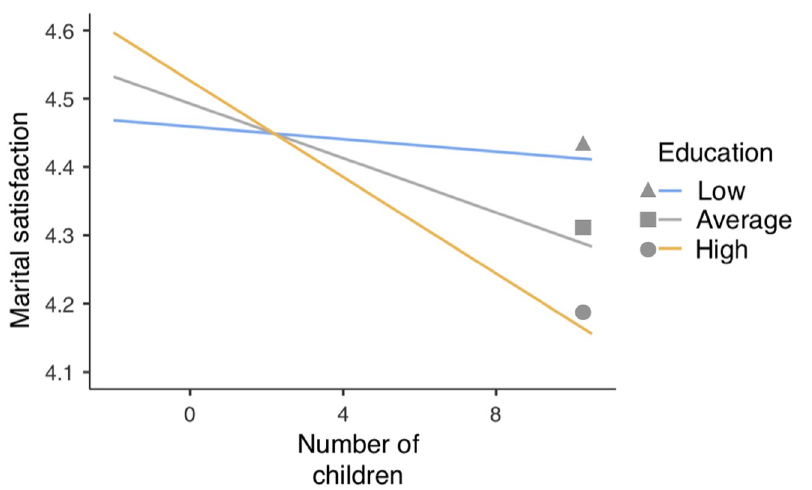
Fig 2. Interaction of the number of children and education in relation to marital satisfaction